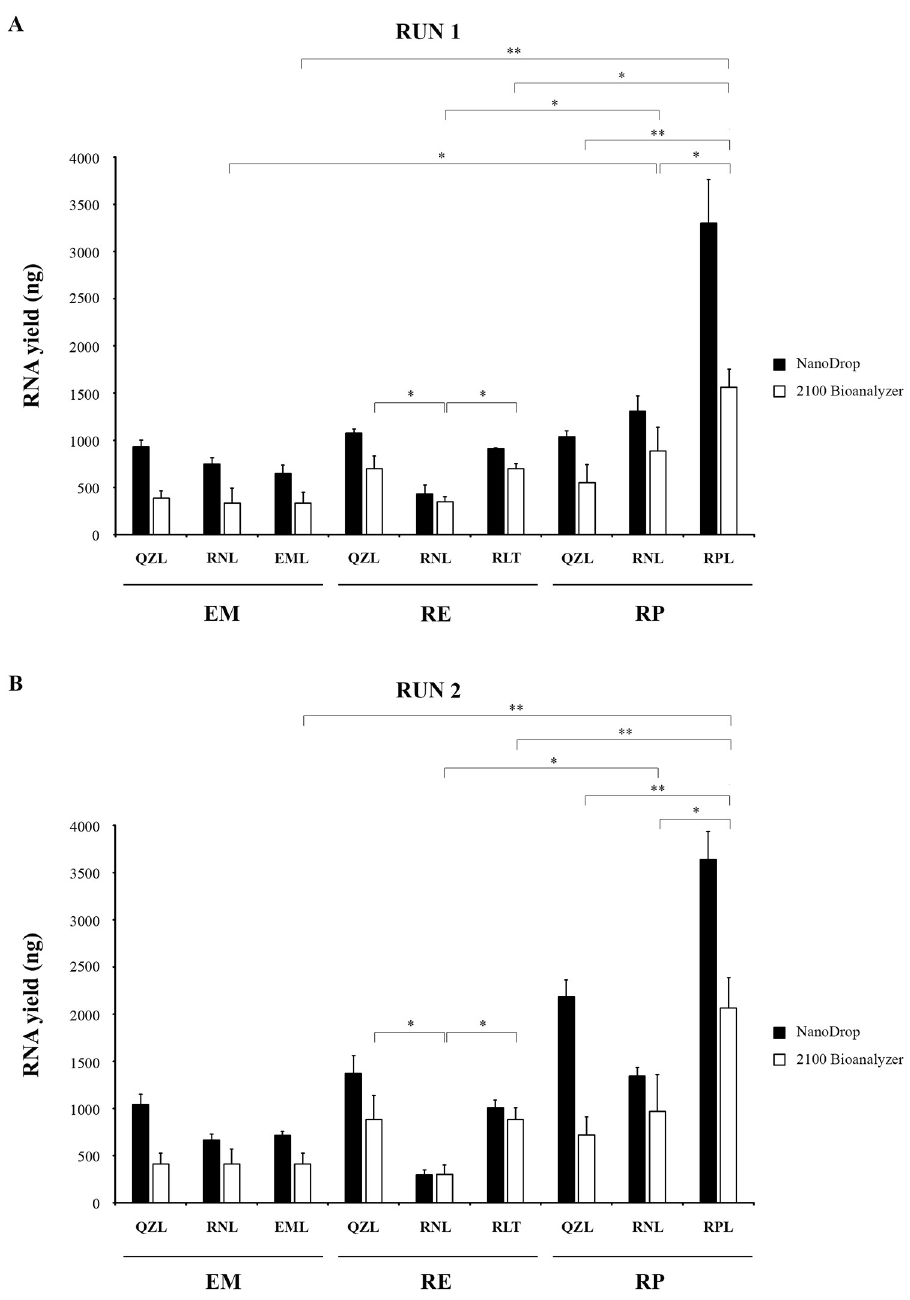
Fig 2. RNA yield according to NanoDrop spectrophotometer (black bars) and 2100 Bioanalyzer (white bars) for three different extraction kits after storage of PBMCs in three different storage media. A. Run 1. Storage of PBMCs for one day. RNA quantification after storage of RNA for 83 days. B. Run 2. Storage of PBMCs for 83 days. RNA quantification after storage of RNA for 127 days. Error bars represent the standard deviations of results from three independent extractions. Statistically significant differences are marked with one ( p < 0.05) or two ( p < 0.005) asterisks (Linear mixed model for repeated measures). EM: NucliSENS easyMAG; RE: RNeasy Mini Kit; RP: RiboPure RNA Purification Kit–blood; QZL: QIAzol; RNL: RNAlater; EML: easyMAG lysis buffer; RLT: RNeasy lysis buffer; RNL: RNAlater; RPL: RiboPure RNA Purification Kit–blood lysis buffer.